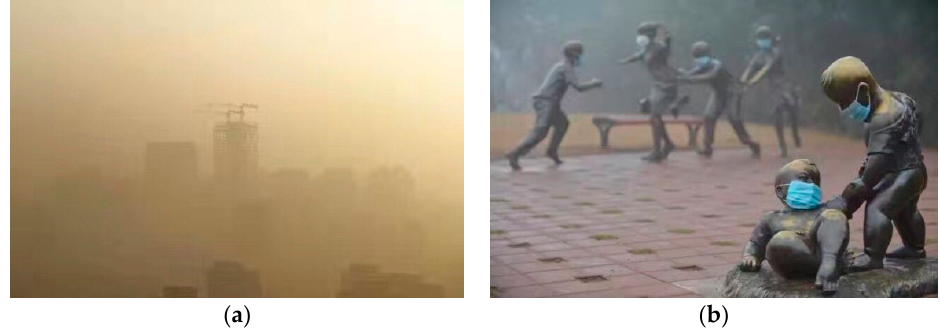
Figure 1. Foggy and hazy weather in Chongqing, China (5 January 2017); ( a ) a tall building that was being built; ( b ) the corner of the park is shown.